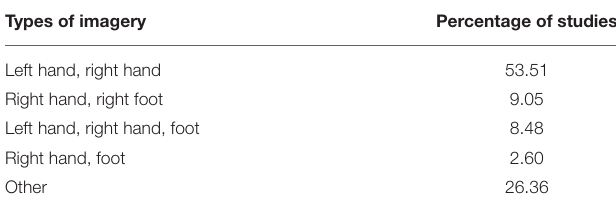
TABLE 2 | Types of imagery used in algorithm